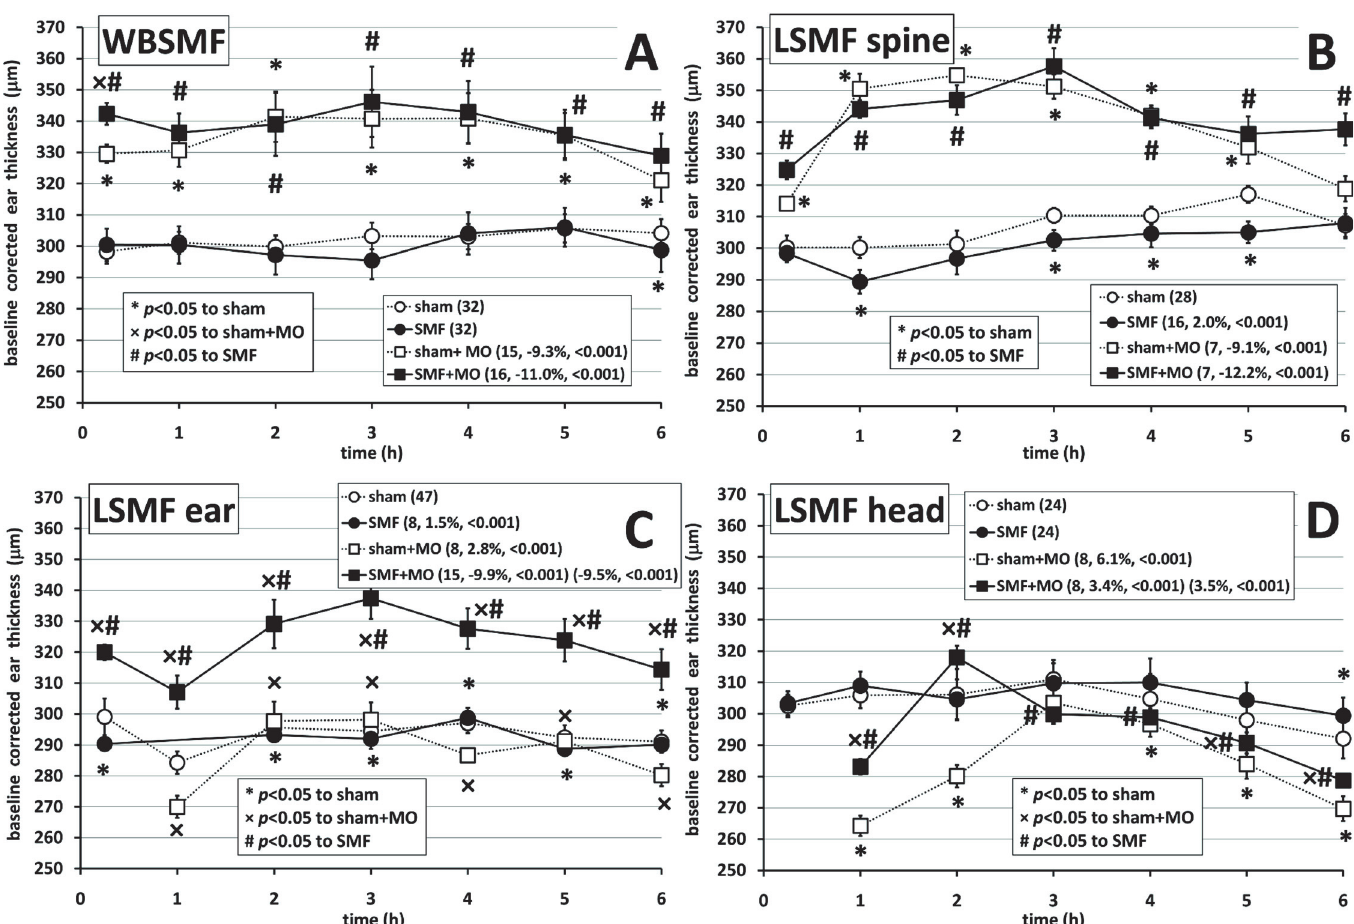
Fig 3. Evolution of average ear thickness in μ m as a function of experimental time (h) for A) whole-body static magnetic field (WBSMF)-exposure, B) local (LSMF)-exposure on the spine, C) LSMF-exposure on the ear, and D) LSMF-exposure on the head. Treatment options appear in the legend: for sham: the number in the parenthesis is the ear number evaluated in the group ( n ). For SMF only and for sham+mustard oil (MO): the first number in the parenthesis is n , the second number (if exists) is the effect η , the third number (if exists) is the probability of significant difference ( p ) compared to negative control for the complete 6 h time period. For SMF+MO: the first number in the first parenthesis is n , the second number is η , the third number is p compared to SMF alone; the first number in the second parenthesis (if the second parenthesis exists) is η , the second number is p compared to positive control. * , ×, and/ or # above or below the markers show significant differences to negative, positive controls, and/or SMF alone, respectively at the specific time point. Lines connecting markers guide the eye only. Error bars show standard errors of the mean (SEM). All differences were estimated by Games-Howell post hoc